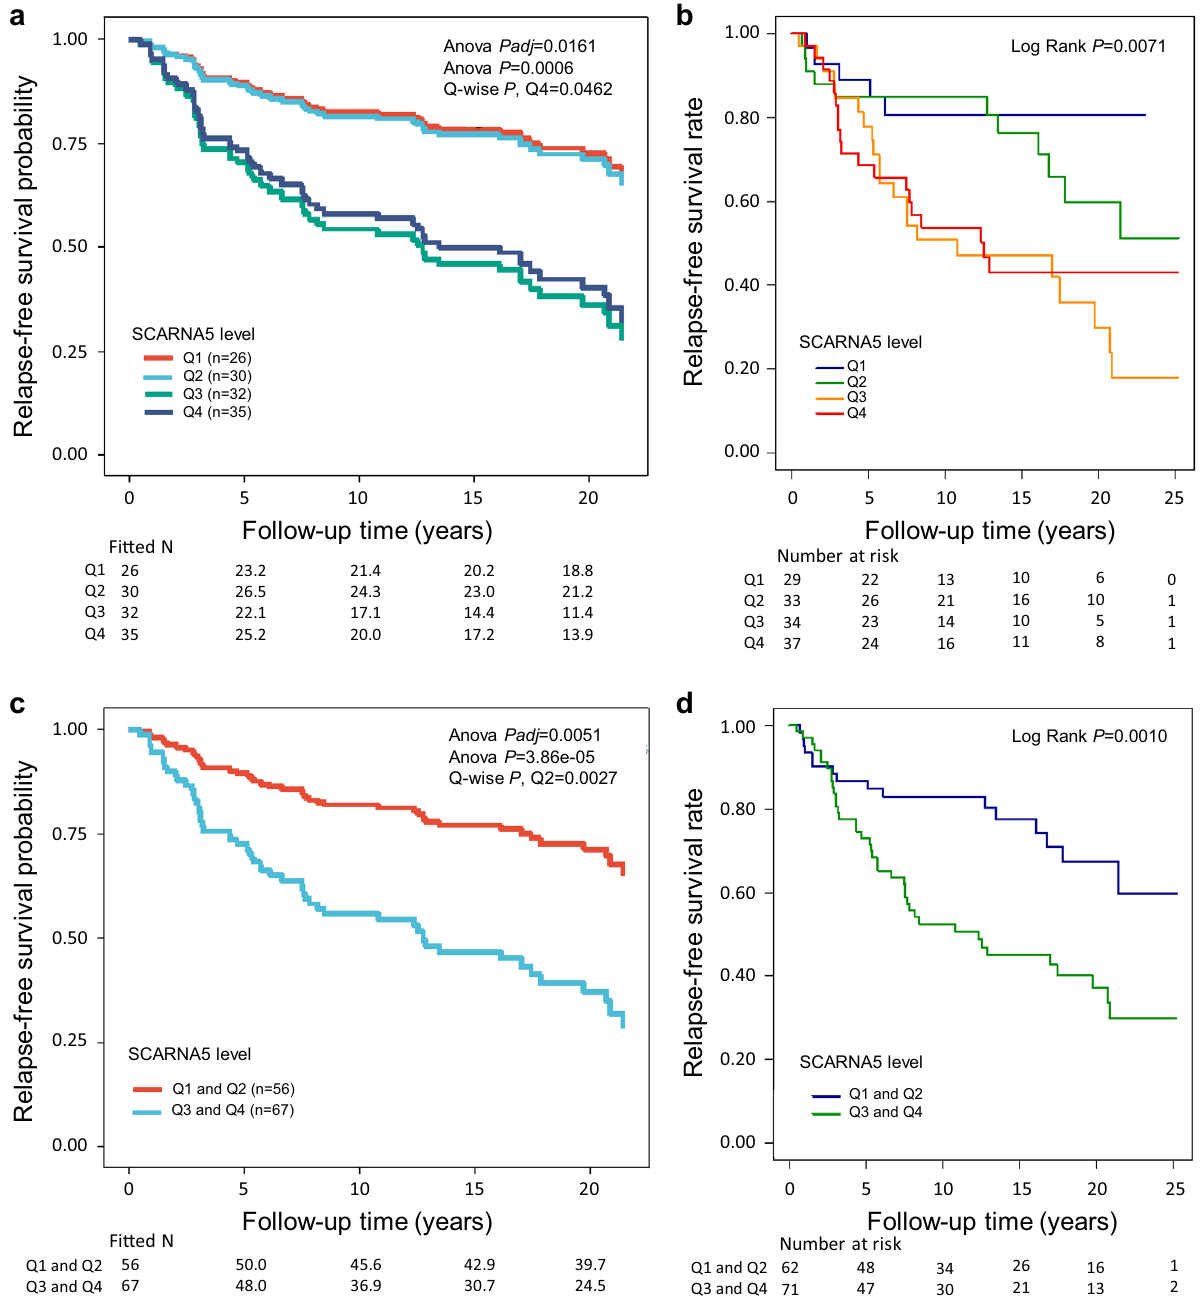
Figure 5. SCARNA5 showed prognostic potential in ER positive invasive local BC. ( a ) The highest quartile (Q4) of SCARNA5 significantly associated with poorer RFS (Overall Padj = 0.0161, Overall P = 0.0006, for Q4 P = 0.0462, HR [CI 95%] = 3.04 [1.02–9.08]), when compared to the lowest quartile (Q1) in ER positive cases (invasive local, n = 123) in the Cox multivariate analysis including the covariates tumor grade, histology and size, nodal status, PR status, HER2 status, age at diagnosis, and the treatment parameters RT (yes/no), CT (yes/no), and adjuvant ET (yes/no). Of the covariates nodal status (Overall P = 0.0096, for node positivity P = 0.0063, HR [CI 95%] = 2.35 [1.27–4.33]), and age at diagnosis (Overall P = 0.015, for age class ≤ 39 P = 0.0013, HR [CI 95%] = 4.68 [1.85–12.02]) significantly associated with RFS in the multivariate analysis. ( b ) Kaplan–Meier plot showing the association of SCARNA5 with RFS in the univariate analysis (Overall Log Rank P = 0.0071) in the invasive local, ER positive cases (n = 133). ( c ) The higher level of SCARNA5 associated with poorer RFS (Overall Padj = 0.0051, Overall P = 3.86e − 05, for higher half P = 0.0027, HR [CI 95%] = 2.79 [1.43–5.44]) in the cases with invasive local, ER positive BC also when the expression level was divided into two groups according to median in the Cox multivariate analysis including the covariates tumor grade, histology and size, nodal status, PR status, HER2 status, age at diagnosis, and the treatment parameters RT (yes/no), CT (yes/no), and adjuvant ET (yes/no). Also nodal status (Overall P = 0.0086, for node positivity P = 0.0061, HR [CI 95%] = 2.33 [1.27–4.28]), and age at diagnosis (Overall P = 0.014, for age class ≤ 39 P = 0.0010, HR [CI 95%] = 4.64 [1.86–11.61]) remained significant. ( d ) Kaplan–Meier plot showing the association of SCARNA5 with RFS according to median in the univariate analysis (Overall Log Rank P = 0.0010) in the cases with ER positive, invasive local BC (n = 133). In ( a ) and ( c ), the fitted Ns were extrapolated from the multivariate-fitted survival